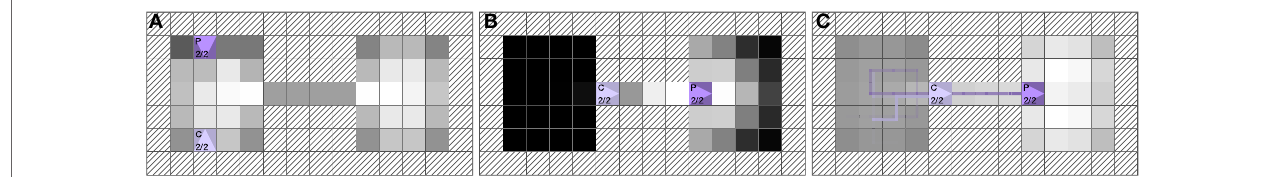
FiGUre 8 | Two room scenario from Guckelsberger and Salge (2016), reproduced with permission. (a) Companion empowerment, n = 2. (B) Companion-player transfer empowerment, n = 2. (C) Coupled empowerment with movement trace, n = 2. In the last subfigure (C) , the companion agent C is driven by a combination of its own empowerment and transfer empowerment from companion to player (values shown in grayscale, bright—high, dark—low). If only companion empowerment is driving the agent, as in subfigure (a) , then the companion does not enter the corridor, as its narrowness will lower the agent’s own empowerment. With the addition of transfer empowerment, however, the companion begins to maintain operational proximity, and thus follows the player also through the narrow corridor. This can be seen in the movement trace of both player and